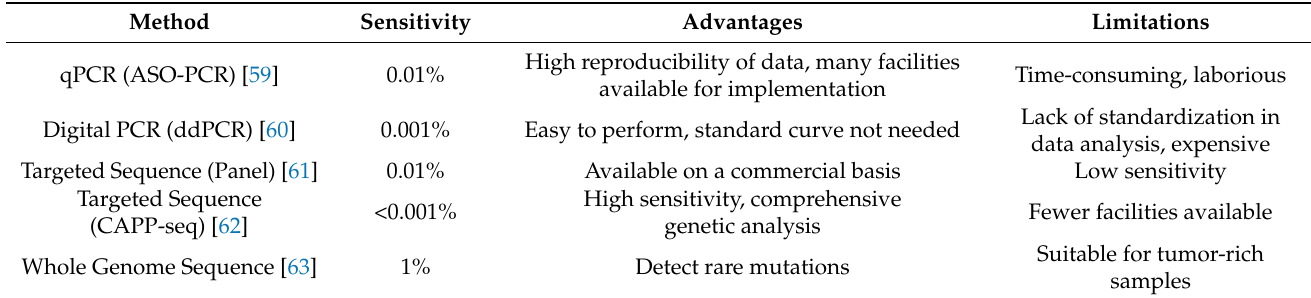
Table 1. Methods of circulating tumor DNA (ctDNA) detection in peripheral